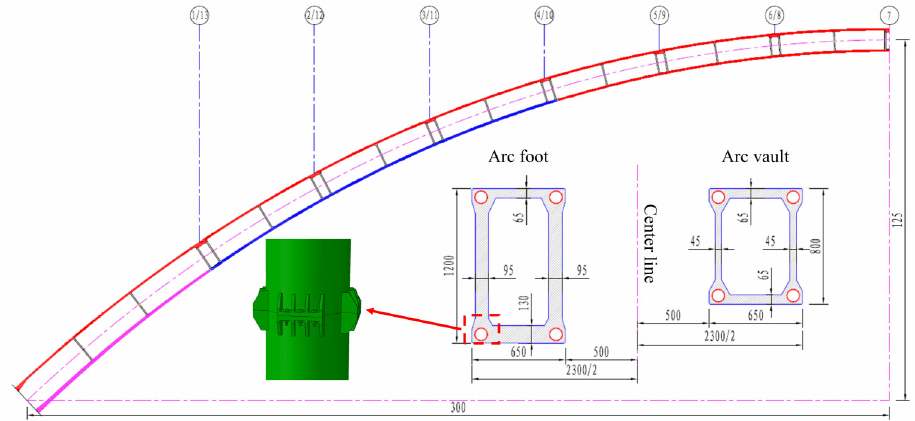
Figure 2. Design scheme of an extra-long span CFST arch bridge.